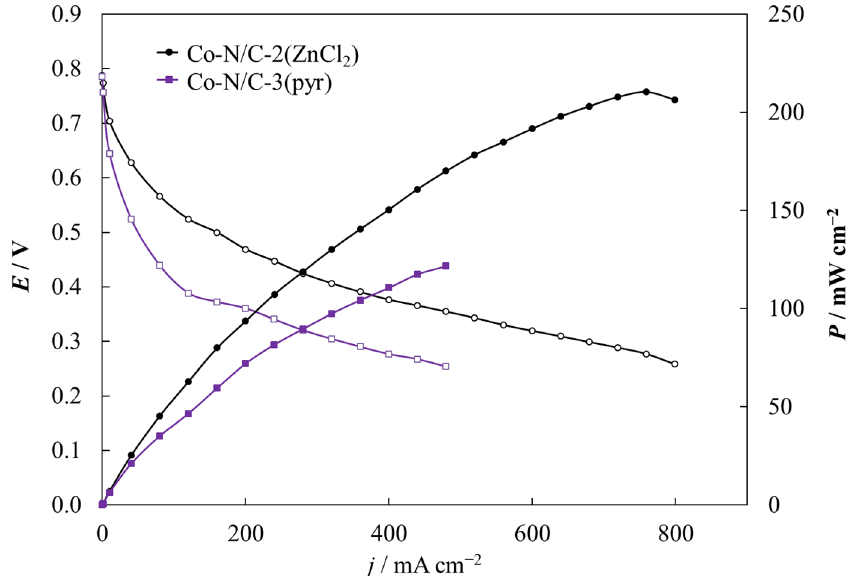
Figure 9. The polarization and power density curves for the assembled single cells with different Co-N/PDC catalysts (noted in Figure). Measurement conditions were as follows: cathode catalyst loading 4.0 ± 0.1 mg cm − 2 , anode catalyst loading 1.0 ± 0.1 mg cm − 2 , cell temperature 80 °C, gas inlet temperature 82 °C, O 2 and H 2 flow rate 200 mL min − 1 , backpressure of gases 100 kPa.